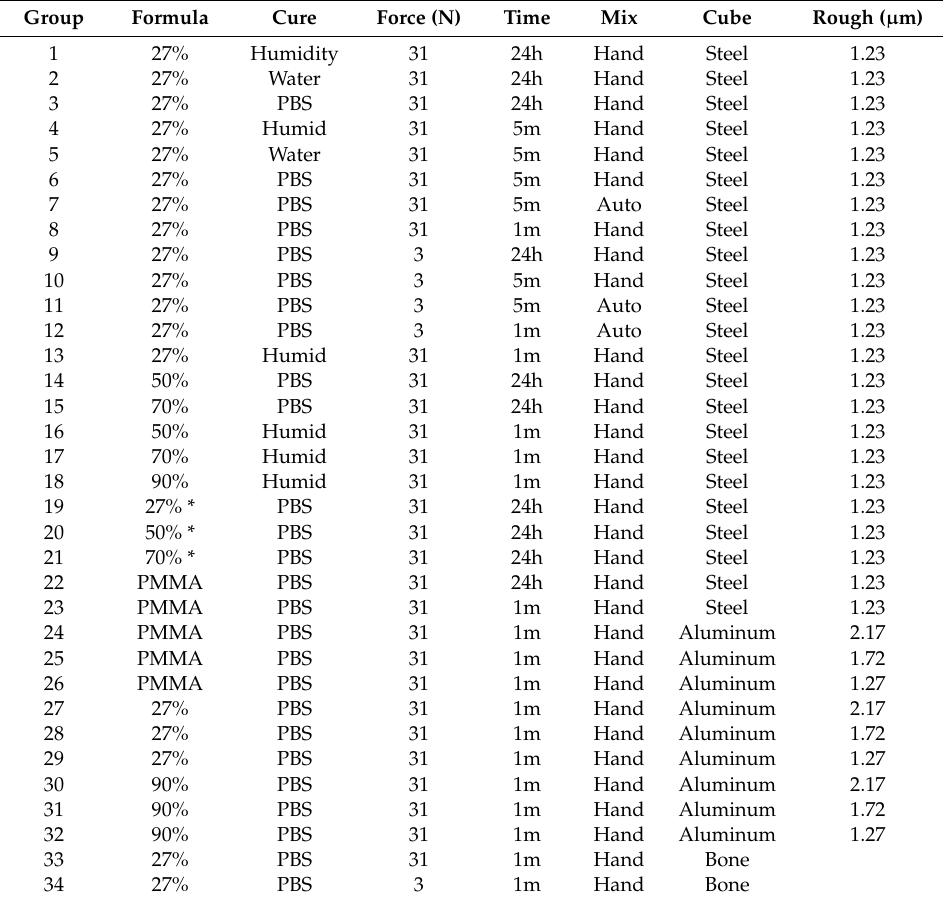
Table A1. Varied factors in each study